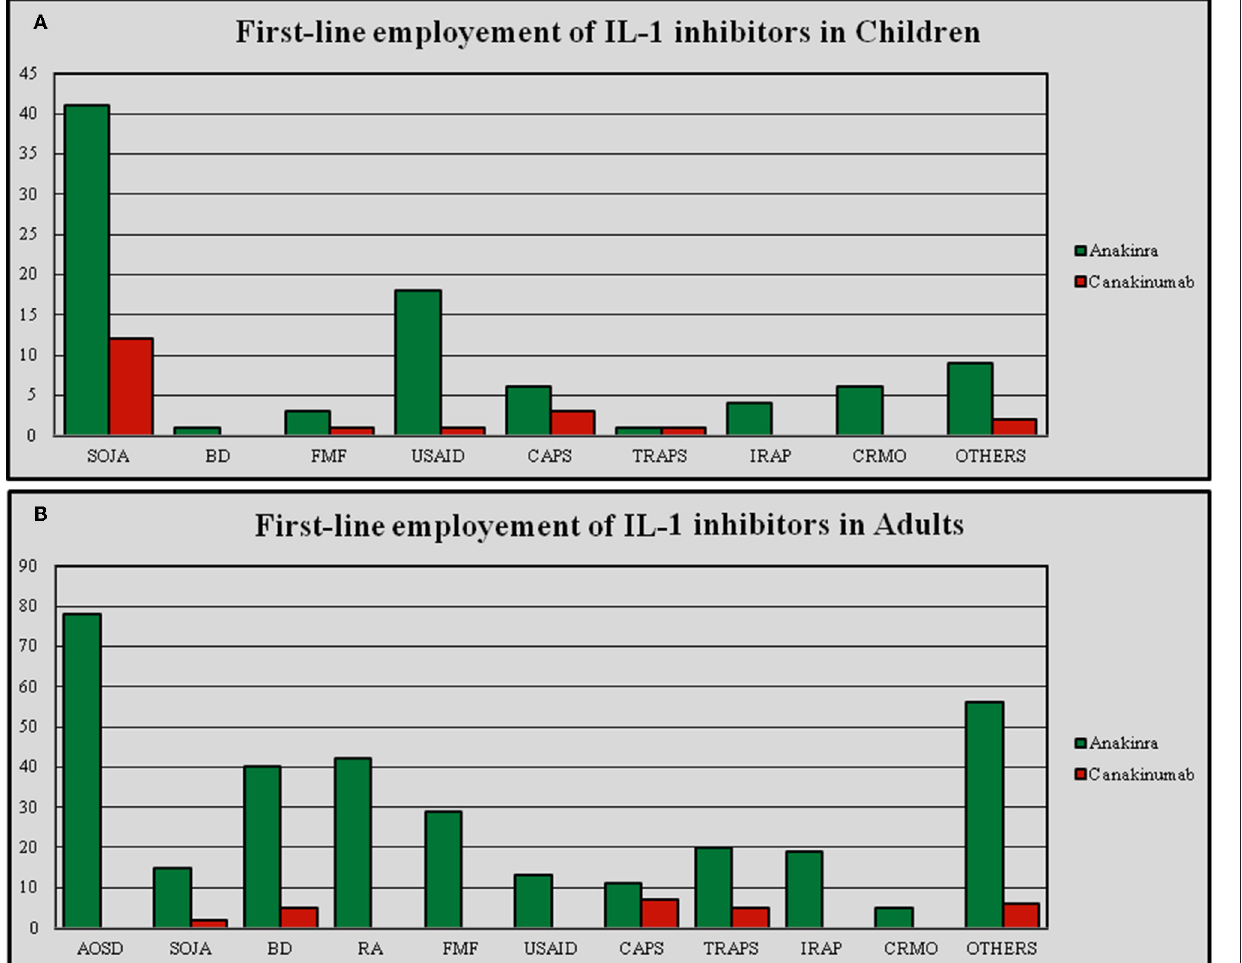
= 0.03, respectively). Table 7 describes the frequency of different AEs according to the age of